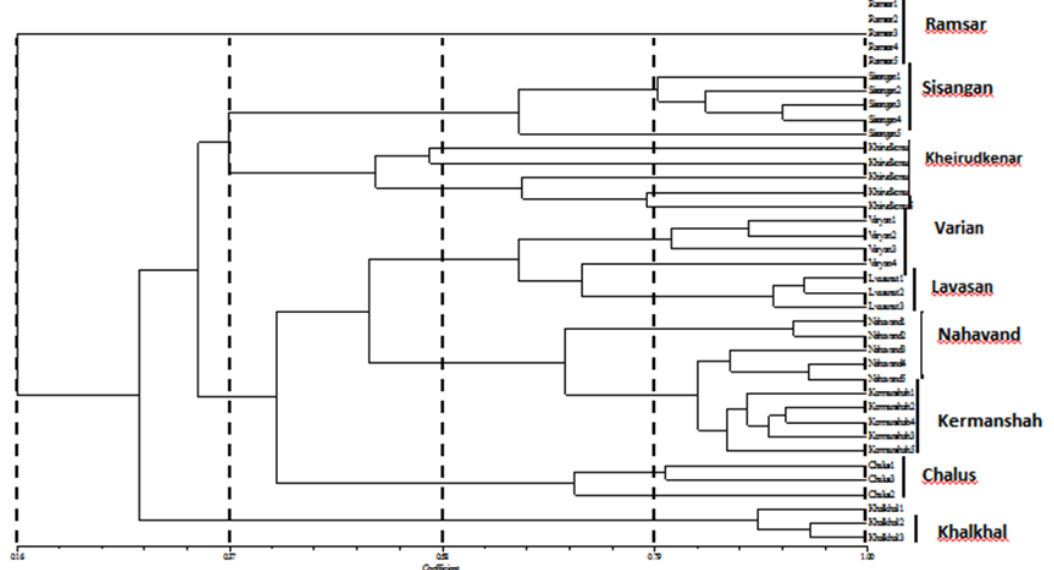
Fig. 4. The results of the cluster analysis of studied violet populations in the RAPD experiment by using UPGMA and JACCARD